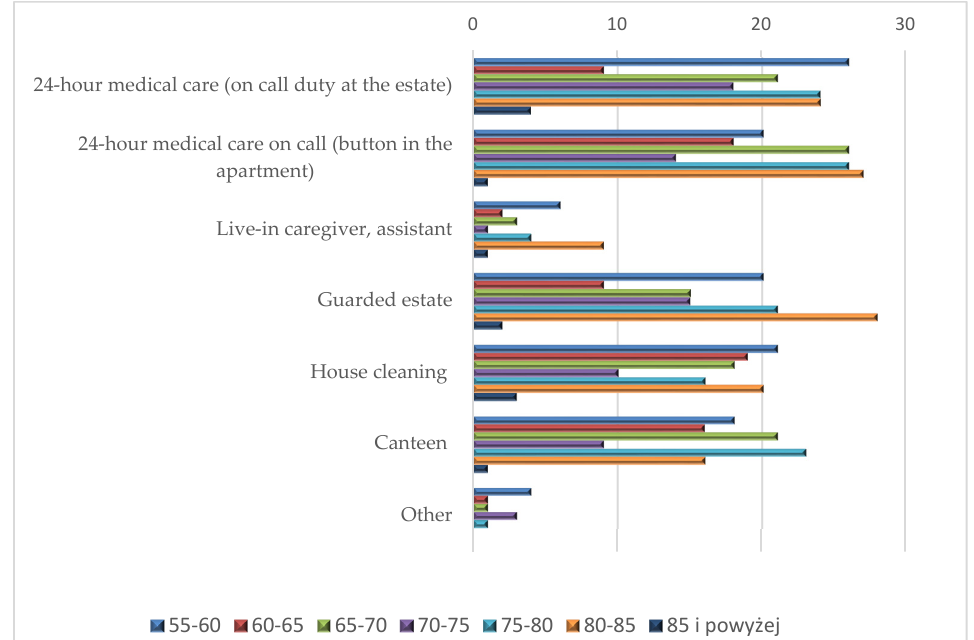
Figure 10. Facilities at a senior housing estate preferred by the respondents by age (number of indications).